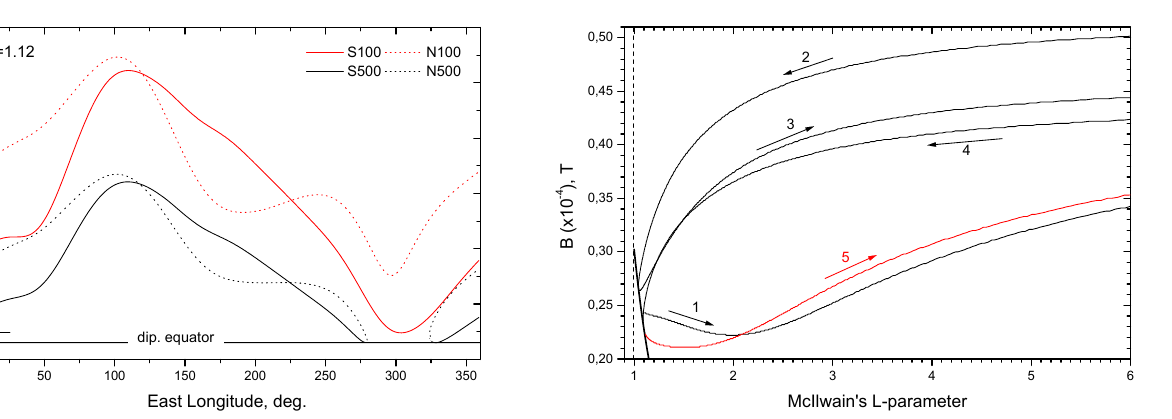
Fig. 5. The trajectory of CORONAS-I in L − B space for a single orbit on day 25 June 1994 (black line). The part of the next orbit is displayed by red. The direction of motion of CORONAS-I is indicated by arrows. Thick line in the left corner indicates dipolar magnetic equator.